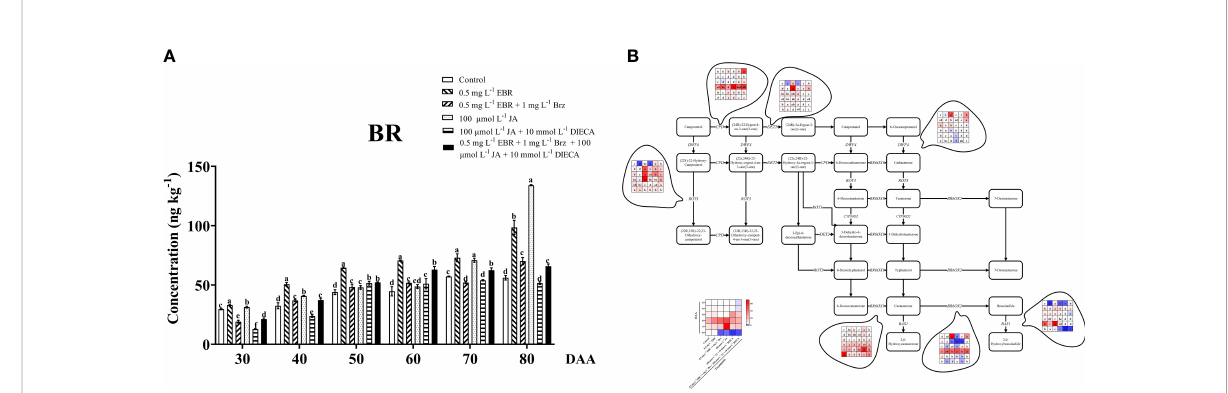
FIGURE 5 Effect of exogenous EBR, JA and their signaling inhibitors on BR biosynthesis and metabolism. (A) Effect of exogenous EBR, JA and their signaling inhibitors on BR contents in different treatment groups (Control, 0.5 mg L -1 EBR, 100 m mol L -1 JA, 0.5 mg L -1 EBR + 1 mg L -1 Brz, 100 m mol L -1 JA + 10 mmol L -1 DIECA, 0.5 mg L -1 EBR + 1 mg L -1 Brz + 100 m mol L -1 JA + 10 mmol L -1 DIECA) at six sampling stages (DAA 30, 40, 50, 60, 70, 80). The levels of BR were expressed in the form of a histogram. Error bars = ± SE (n ≥ 3). Signi fi cant differences among samples have been displayed by a – f letters (one-way ANOVA, P<0.05). (B) Expression of genes involved in BR biosynthesis and metabolic pathways in different treatment groups (Control, 0.5 mg L -1 EBR, 100 m mol L -1 JA, 0.5 mg L -1 EBR + 1 mg L -1 Brz, 100 m mol L -1 JA + 10 mmol L -1 DIECA, 0.5 mg L